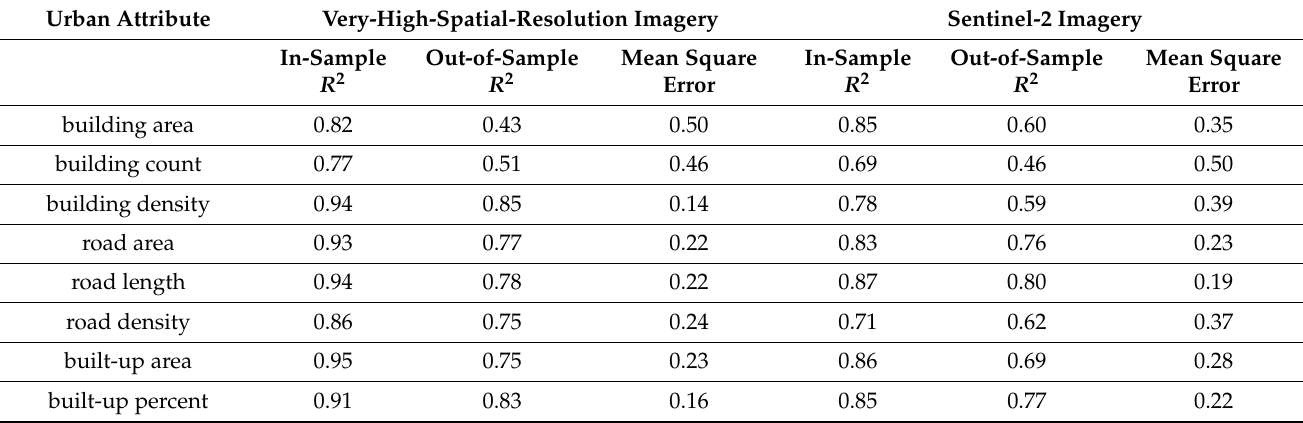
Table 7. R 2 and mean square error values for urban attributes using elastic net regularization models at different spatial resolutions for Sri Lanka (192 Grama Niladhari Divisions).